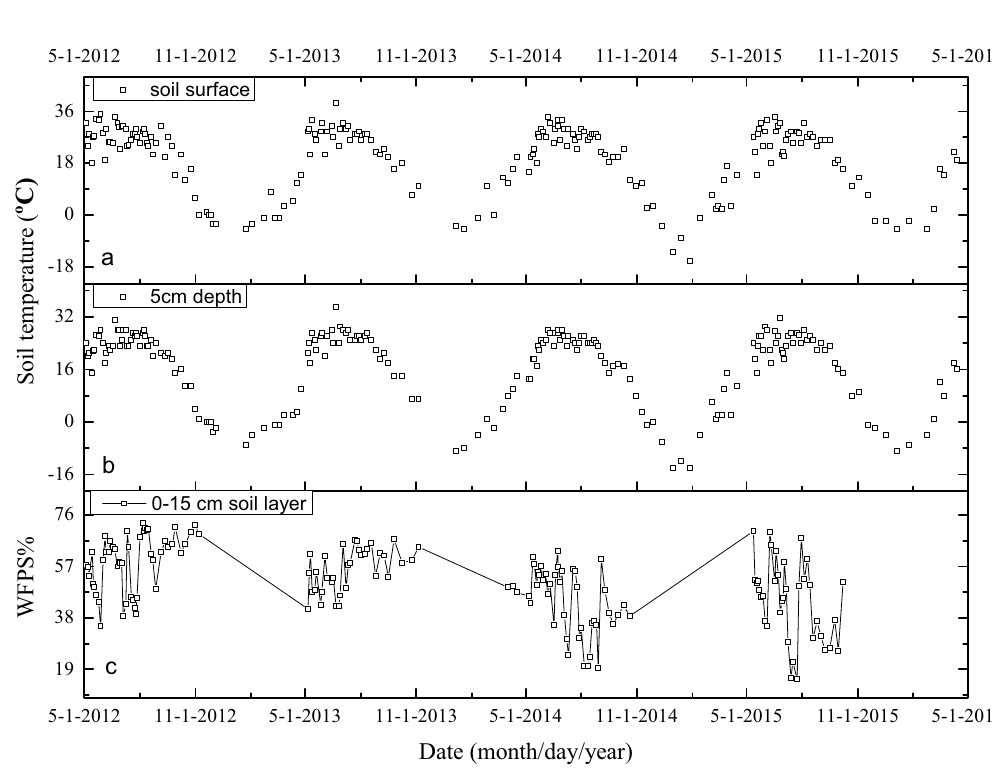
Figure 2. Seasonal variations in soil temperature (at soil surface and 5 cm soil depth) and WFPS% at 0–15 cm depth from May 2012 to April